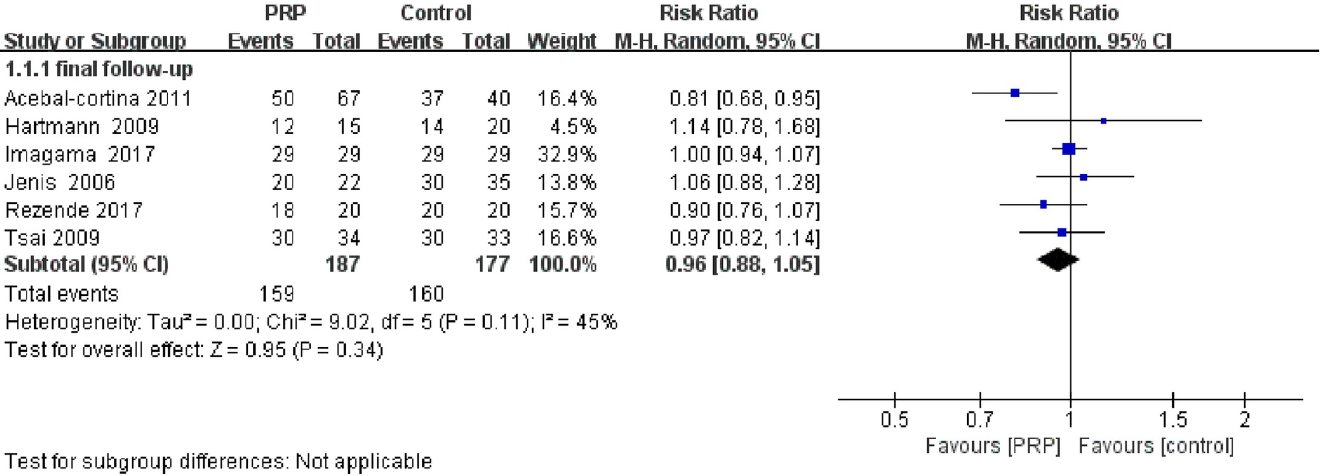
achieved a shorter time of bone union (7.8 ± 0.6 vs 9.8 ± 0.6 months). Data on the fusion rate and time needed for bony fusion in RCTs were not available for a pooled analysis because of the varied definitions and methods for evaluating fusion. A meta-analysis was performed in 6 cohort studies, as the study in which Castro et al. reported a fusion rate based on the fusion level was excluded from the present analysis. The pooled analysis did not show that PRP treat- ment was able to significantly increase the fusion rate in the final follow-up (RR = 0.96, 95% CI: 0.88–1.05, P = 0.11); however, there were no available data to perform a subgroup analysis evaluating the fusion rate at different timepoints postoperatively (Fig 2).